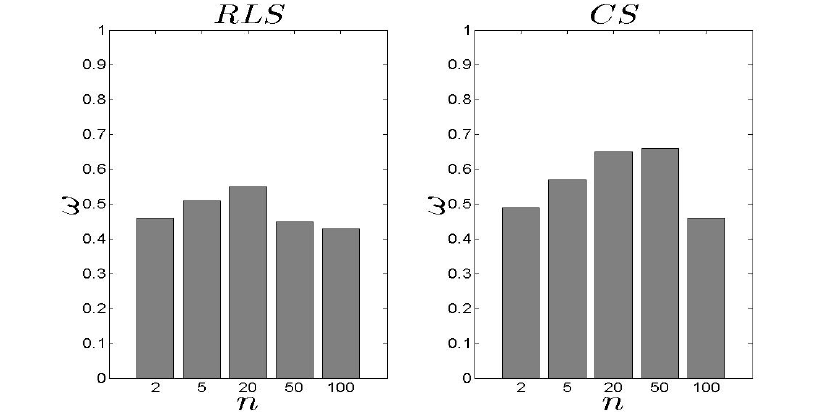
Figure 6. RLS and CS results for the ω metric ( |F| = 10).